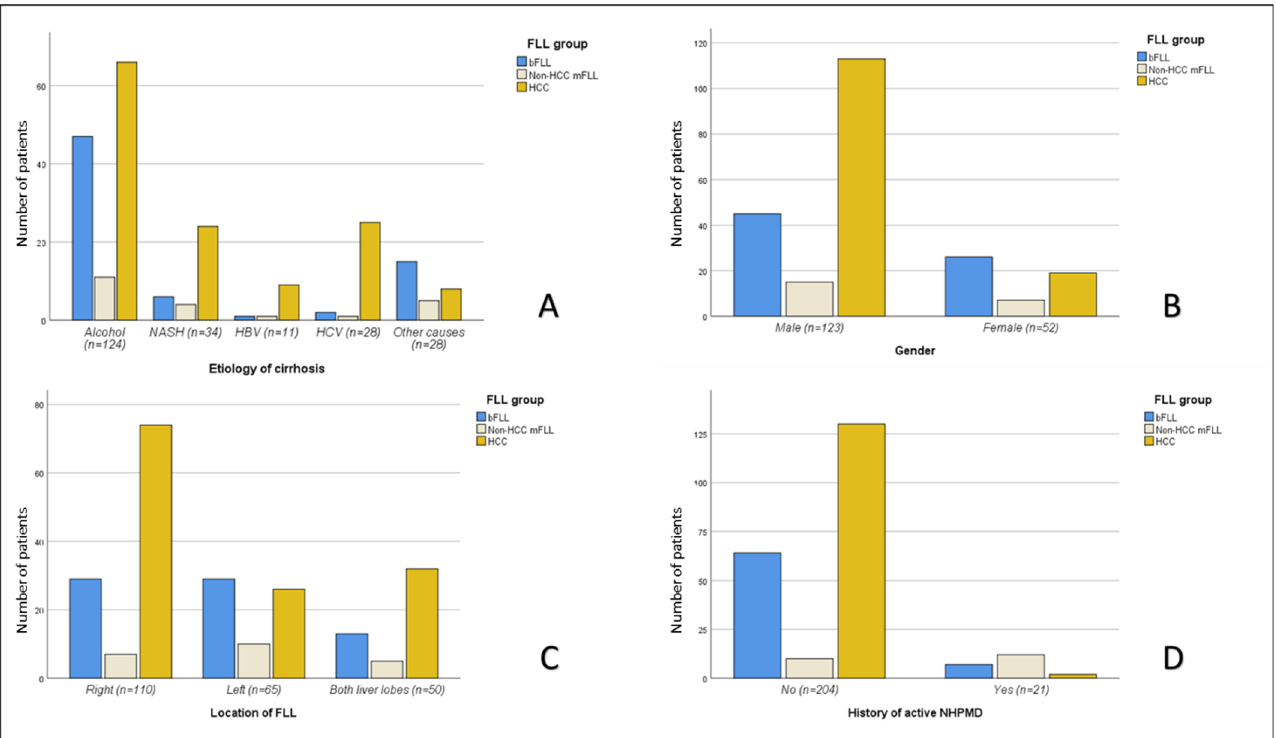
Figure 4. The differences in the etiological distribution of the three major FLL groups (bFLLs and HCC and non-HCC mFLLs) among the 225 study subjects, according to the etiology of cirrhosis ( A ), gender ( B ), lobar distribution ( C ), and history of active non-hepatic primary malignant disease (NHPMD) ( D ). FLL, focal liver lesion; bFLL, benign focal liver lesion; mFLL, malignant focal liver lesion; HCC, hepatocellular